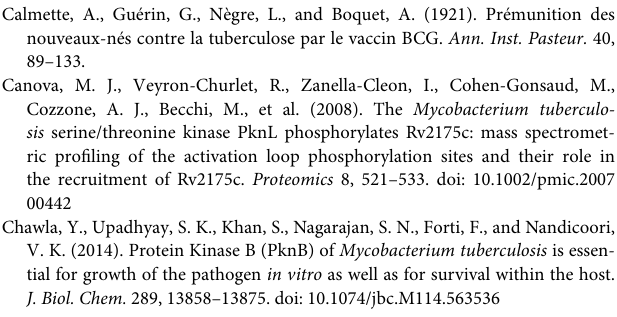
Supplementary Table S1A | Spreadsheet of all the identified protein groups, phosphopeptides and phosphoproteins from M. bovis BCG. Supplementary Table S1B | Spreadsheet of all the identified protein groups, phosphopeptides and phosphoproteins from M.